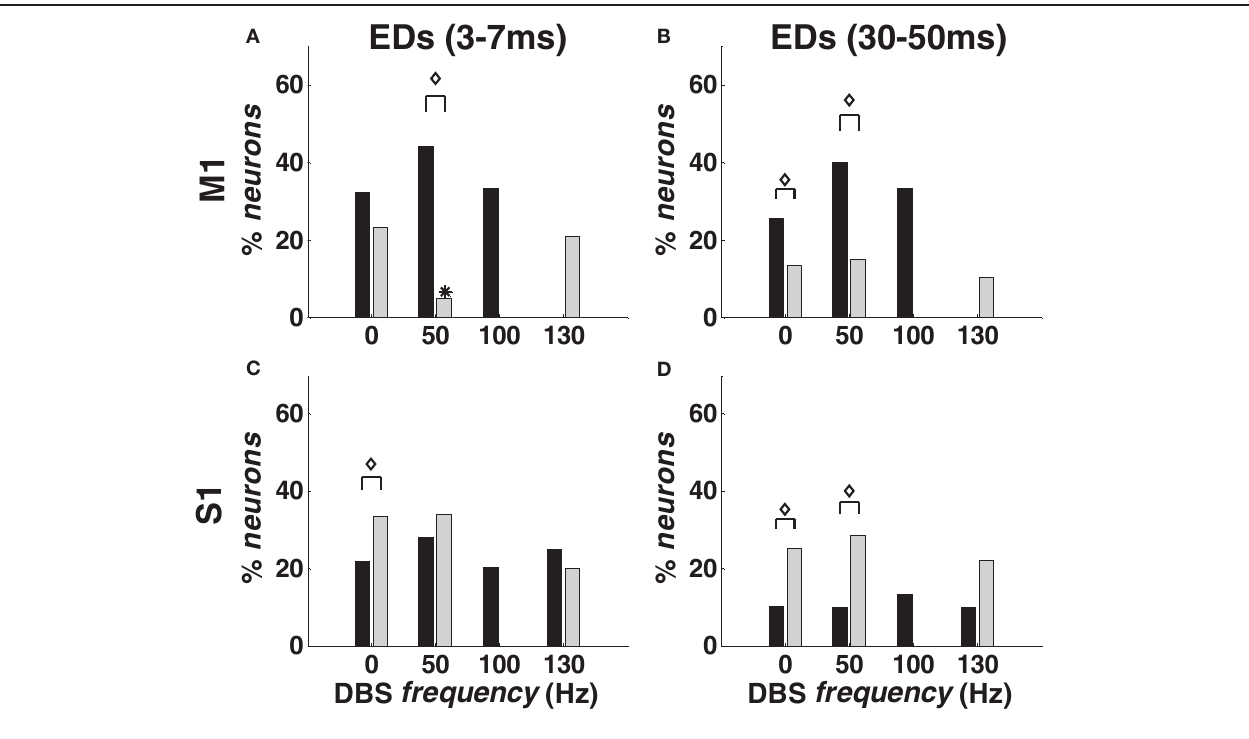
FIGURE 6 | Temporal ensemble dependencies (EDs) in M1 (A,B) and S1 (C,D) cortex in normal and MPTP conditions (animal A), both at rest (0Hz) and during DBS (50, 100, 130Hz). (A,C) Percentage of neurons with